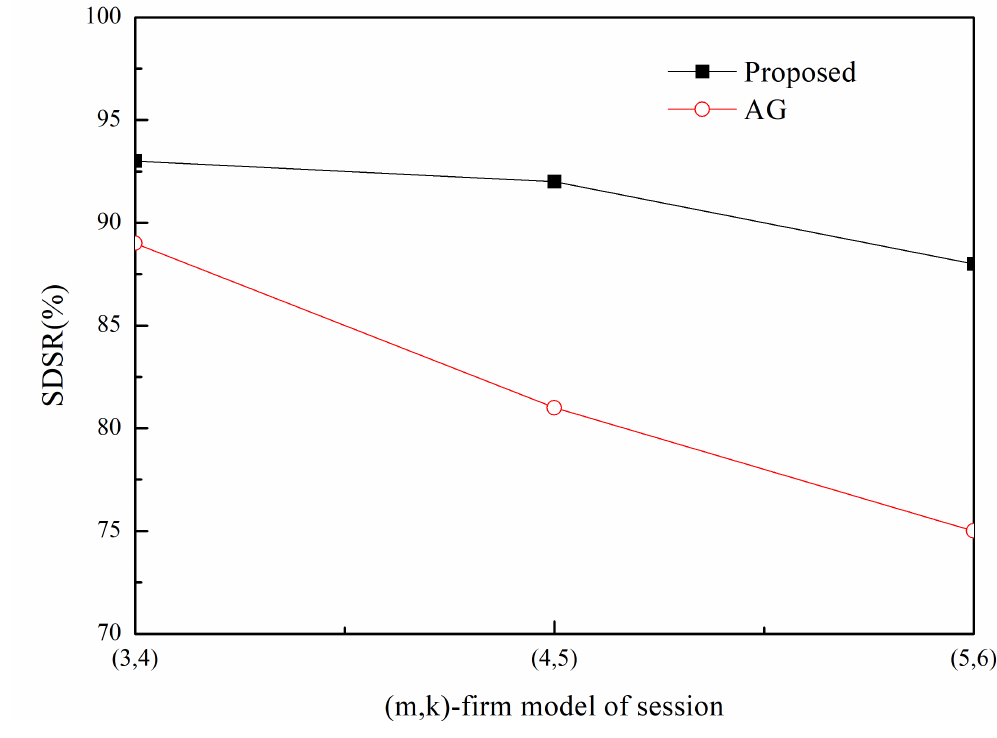
Figure 3. SDSR for (2,3)-firm